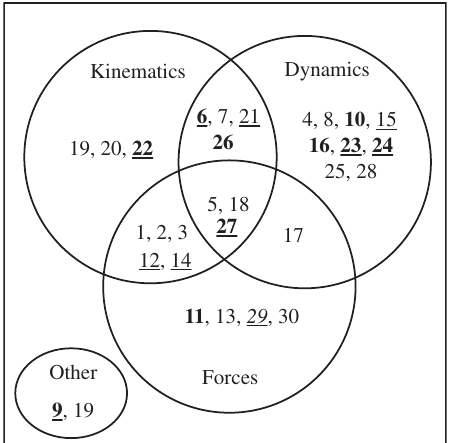
FIG. 3. Venn diagram of the distribution of problems in the FCI. Items in bold are the blocked items removed from the analysis. Underlined items are items identified as unfair to men or women by Traxler et al. [16] (Item 29 was identified as fair but